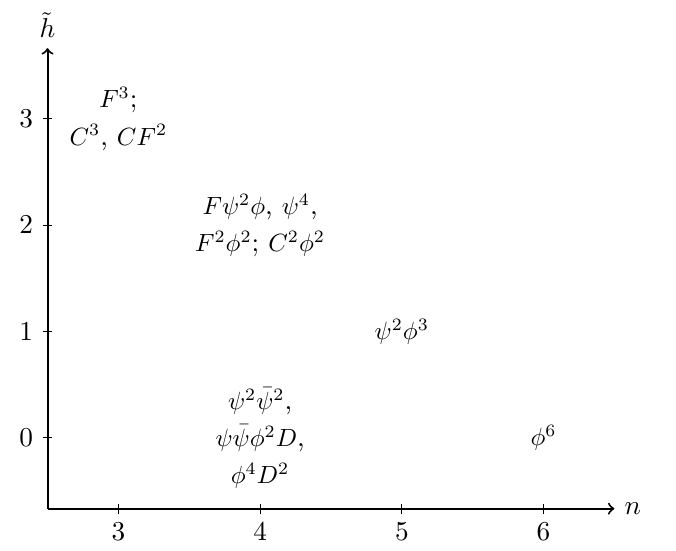
Figure 3 . Classes of O (Λ − 2 ) amplitudes in a generic theory including gravity, with gravitational amplitudes separated by a semicolon. Each class is characterized according to the modified helicity and number of external particles that the amplitude carries. The non-renormalization theorem in eq. (3.7) implies that a Wilson coefficient C j can only renormalize a C i on its right, with the further condition that it lies inside the cone ˜ h i ≤ ˜ h j ± ( n i − n j ) . Our notation for contact amplitudes reflects the operator language, for example A is generated by an operator with a ‘right-handed’ Weyl CF 2 tensor [23] and two right-handed field strength tensors. A bar denotes the left-handed counterpart, and D counts the number of derivatives that the operator